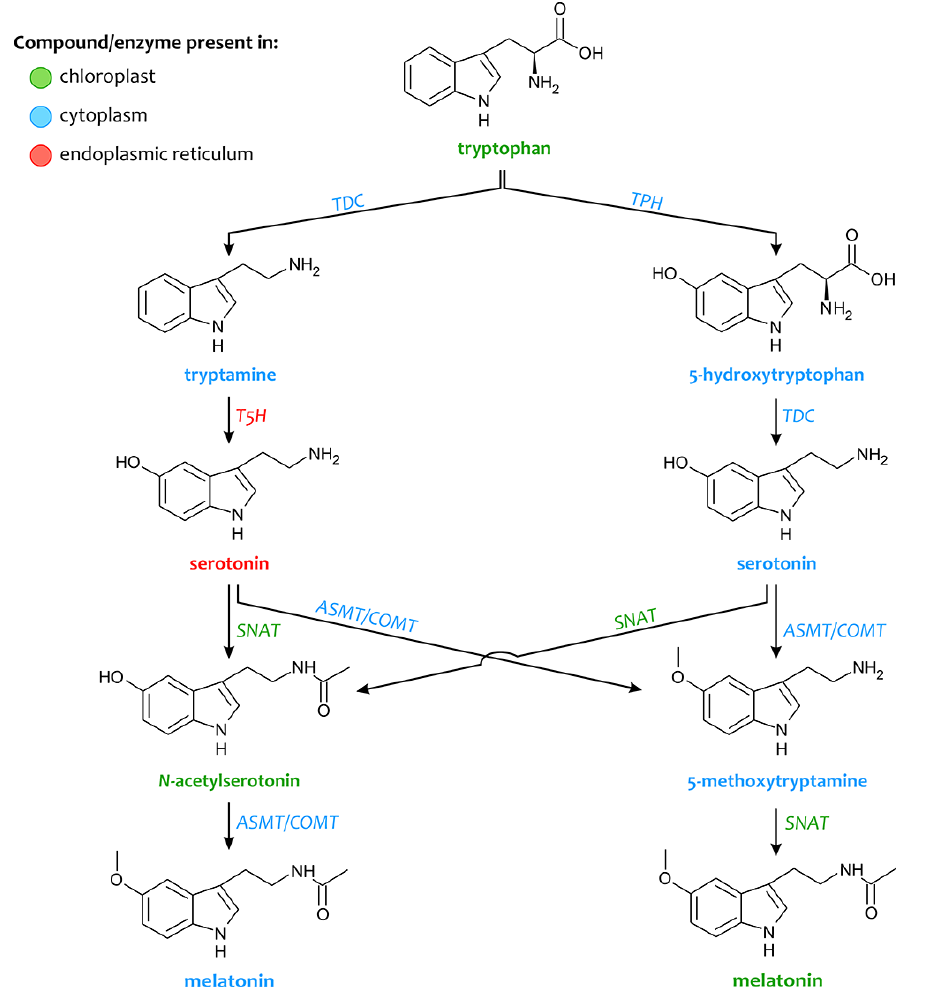
Figure 1 Generalized diagram of four biosynthetic pathways of melatonin in a plant with distinction to